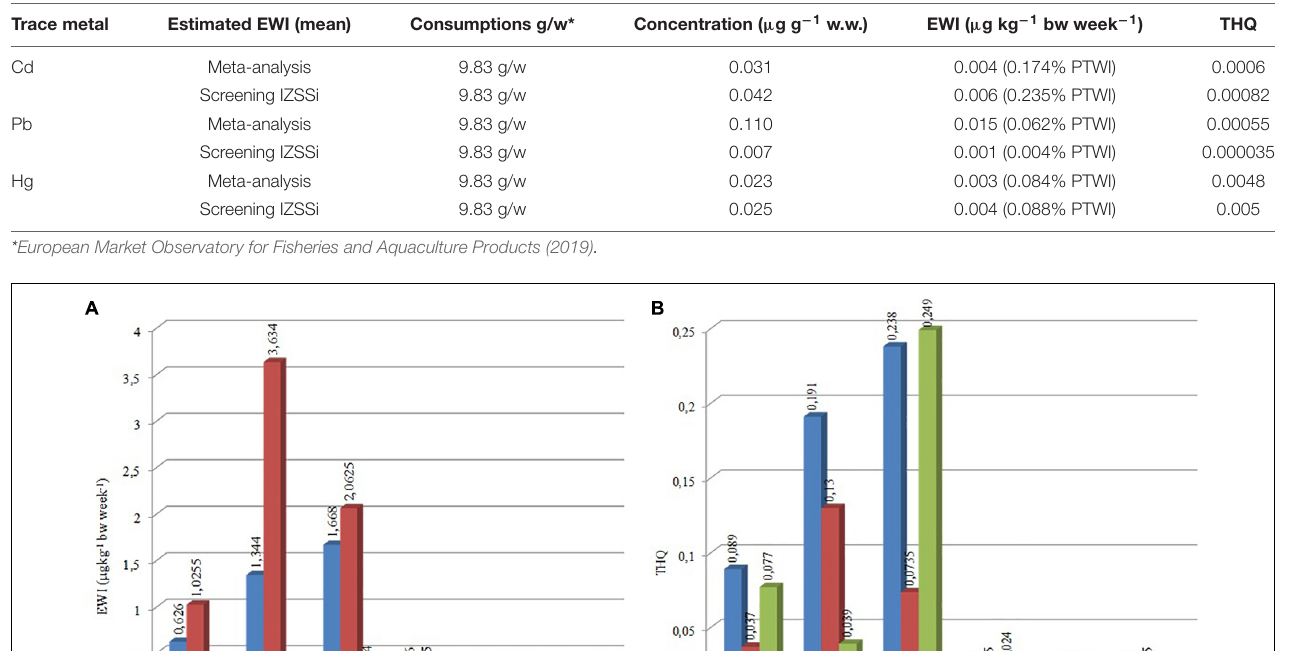
TABLE 3 | Estimated weekly intakes (EWIs and EWIs compared to PTWIs) and target hazard quotients (THQs) for individual metals (Cd, Pb, and Hg) by consumption and concentrations observed in meta-analysis and screening of farmed sea